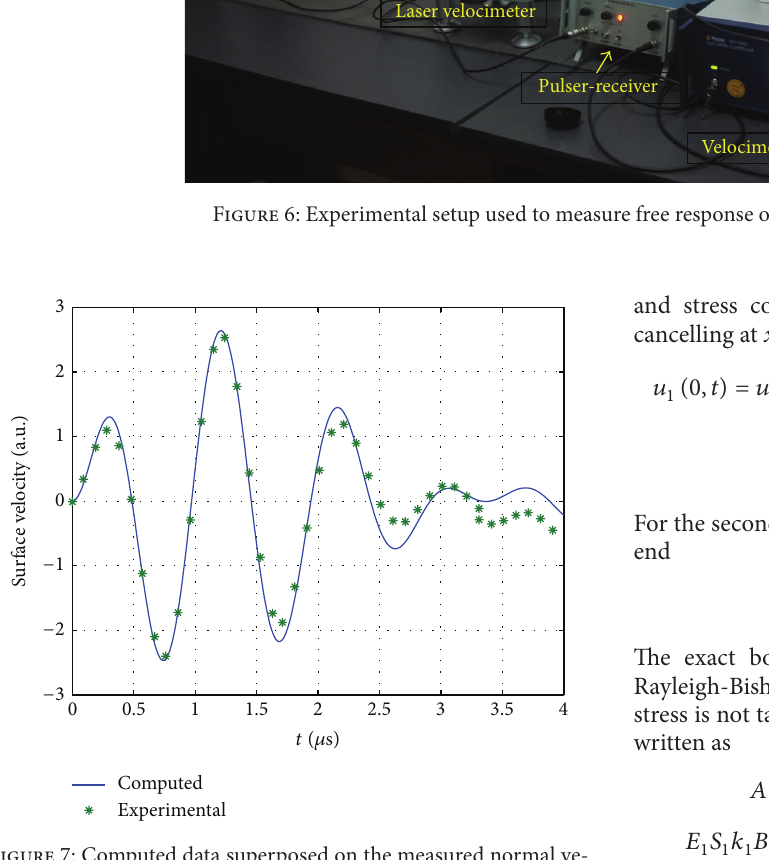
Figure 7: Computed data superposed on the measured normal ve- locity on transducer